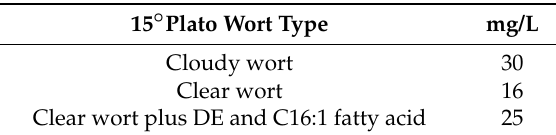
Table 7. Ethyl acetate concentration (mg/L) following 160 h fermentation of different 15 ◦ Plato wort types [32].